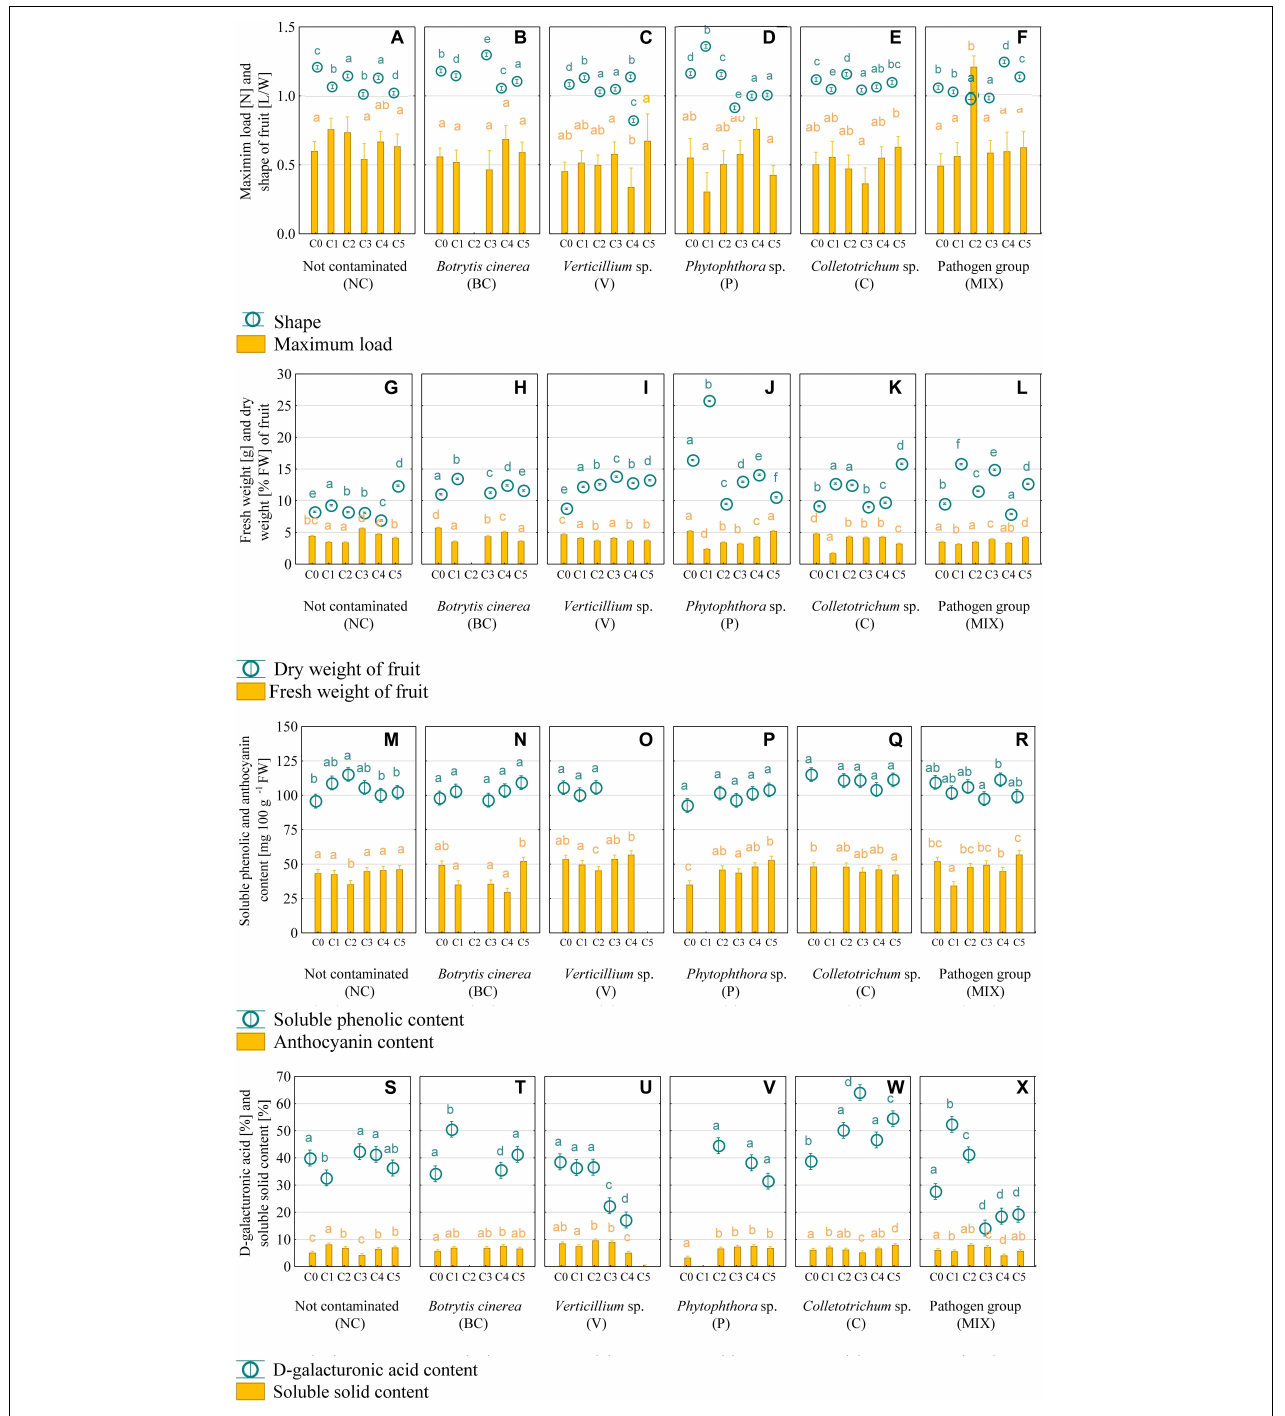
FIGURE 2 | Firmness of strawberries and shape (A–F) , fresh and dry weight (G–L) , soluble phenolic and anthocyanin content (M–R) , and D -galacturonic acid and soluble solid content (S–X) in strawberry fruit. C0, control (not contaminated); C1, Consortium 1; C2, Consortium 2; C3, Consortium 3; C4, Consortium 4; C5, Consortium 5. A statistical analysis was performed for each pathogen group of plants separately. The data are means ± SD ( n > 3). Different letters (a–f) indicate the differences between consortia ( P < 0.05) as determined by the following statistical test: ANOVA Tuckey test for different N for maximum load (C–E) and shape (A–F) ; F-Welch test and RIR Tuckey test for unequal numbers for (A,B,F) , ANOVA and Tuckey test HSD for fresh weight (G,H,L) , dry weight (L) , anthocyanin (N–Q) , soluble phenolic (N–Q) , D -galacturonic acid (W) , soluble solid content (W,X) ; F-Welch and post hoc for fresh weight (I–K) , dry weight (J,K) , anthocyanin (M,R) , soluble phenolic (M,R) , D -galacturonic acid (S–U,X) , soluble solid content (S–U) ; ANOVA Kruskal–Wallis test for dry weight (G–I) , D -galacturonic acid (V) , soluble solid content (V) .